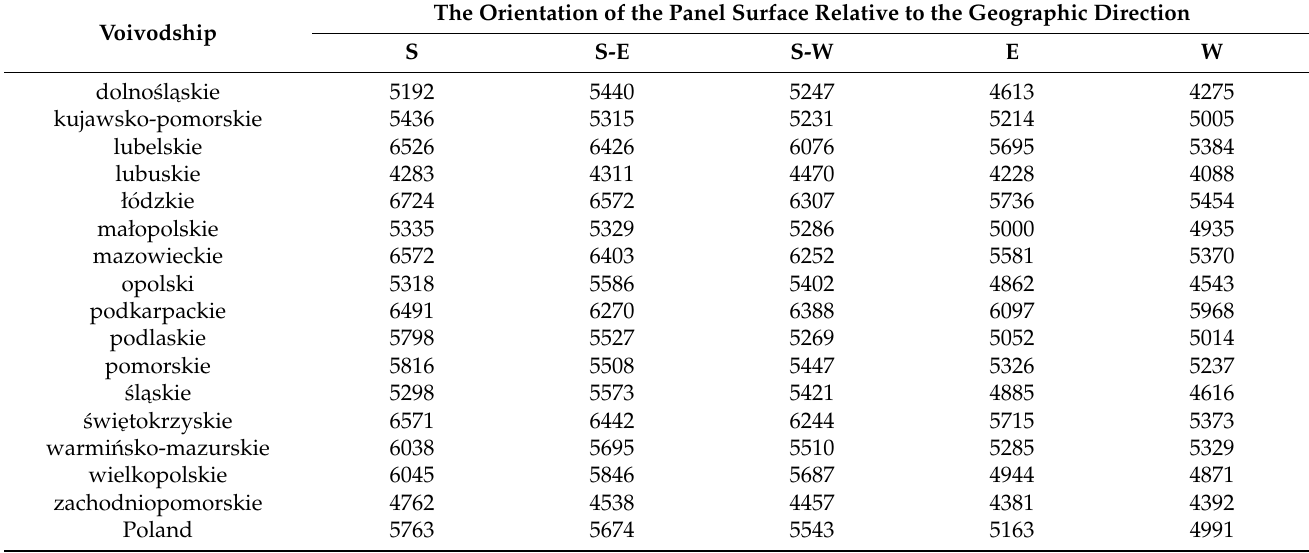
southern orientation, as well as a south-eastern and south-western one. The nationwide